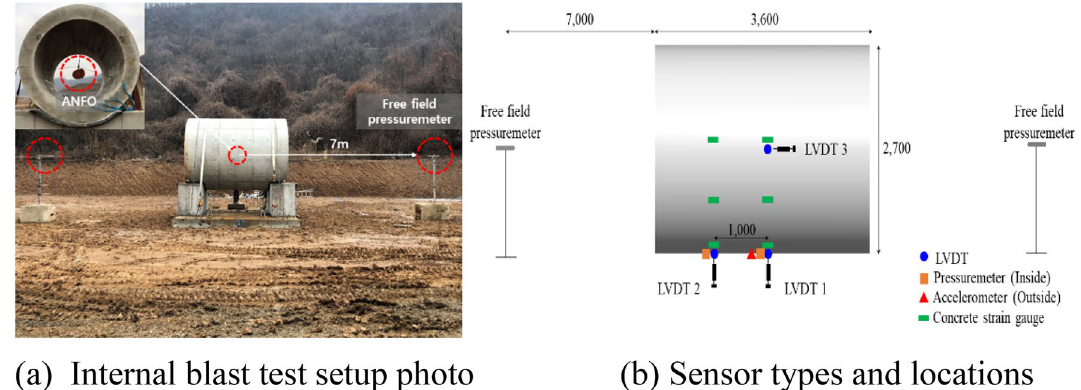
Figure 6. Test setup and measurement details. ( a ) Internal blast test setup photo. ( b ) Sensor types and locations.